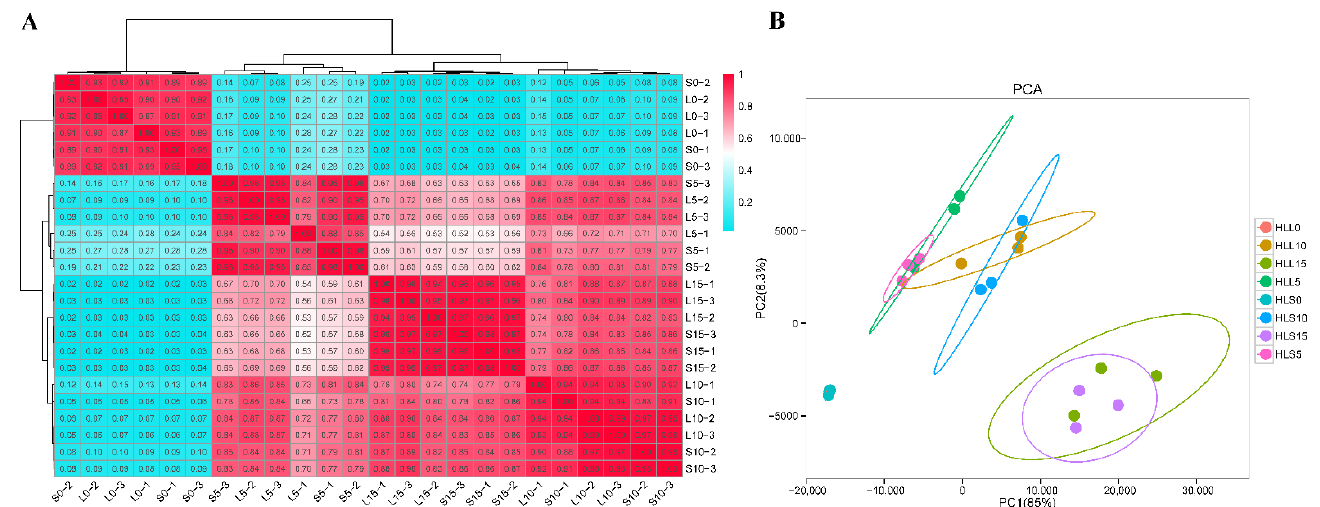
Figure 1. Relationship between 24 fiber samples. ( A ) Pearson’s correlation coefficient and clustering heatmap. The abscissa and ordinate are the number of samples; the order is determined by the correlation clustering results, and the color reflects the correlation between samples. ( B ) Principal component analysis of identified genes. L represents an equal mix of HL-9, HL-62, and HL-194 RNA samples; S represents an equal mix of HL-34, HL-78 and HL-159 RNA samples; 0 means 0 days after flowering ; values 1, 2, 3 represent different biological replicates.